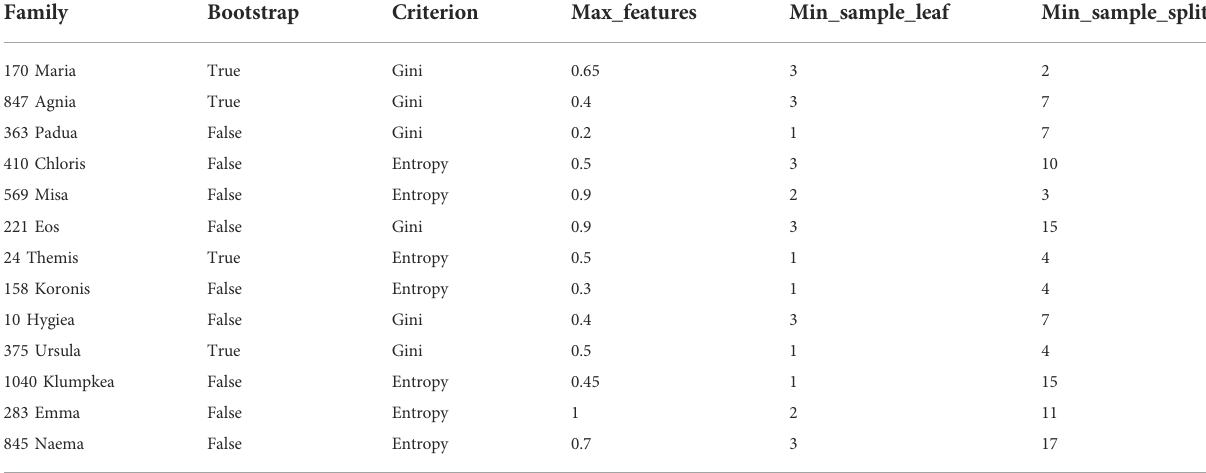
TABLE 2 Extratree and random forest classi fi er machine learning parameters as generated by the TPOT tool, with the number of estimators fi xed at 100. The columns report the asteroid families IDs, the values of bootstrap, criterion, max_features, min_sample_leaf, and min_sample_split. Family